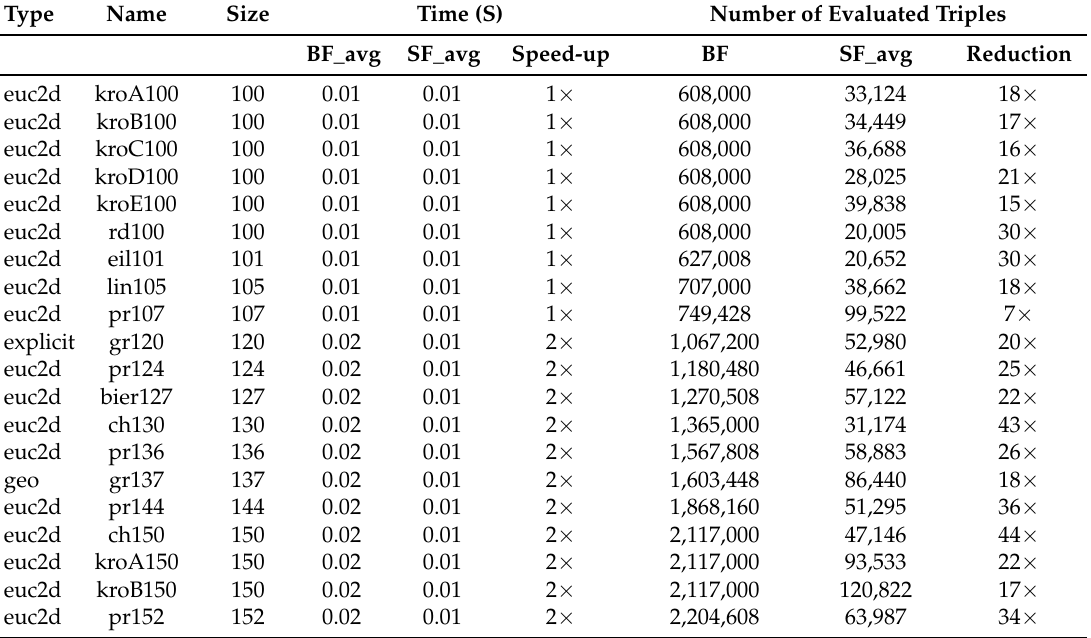
Table 4. Comparing SF and BF in finding one Best Improving move on Traveling Salesman Problem Library (TSPLIB) instances starting from a random tour (averaged over 1000